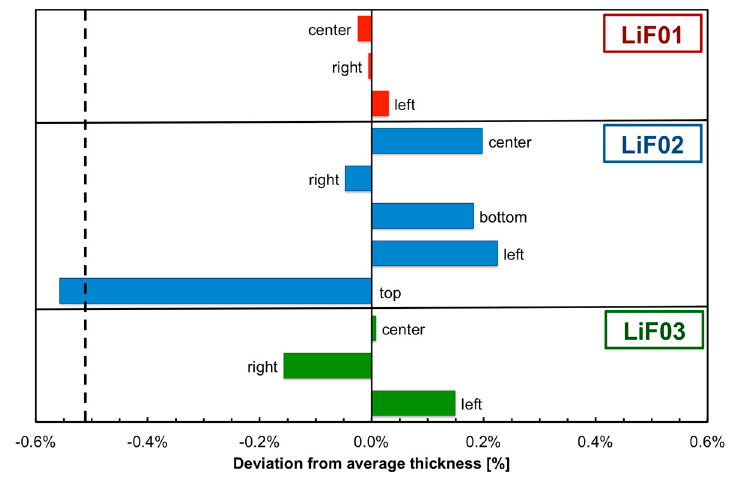
Figure 8. Deviation from the average 6 LiF thickness of the three thin samples. The vertical dashed line refers to the nominal value (1.8 µm) set by means of the quartz oscillator.